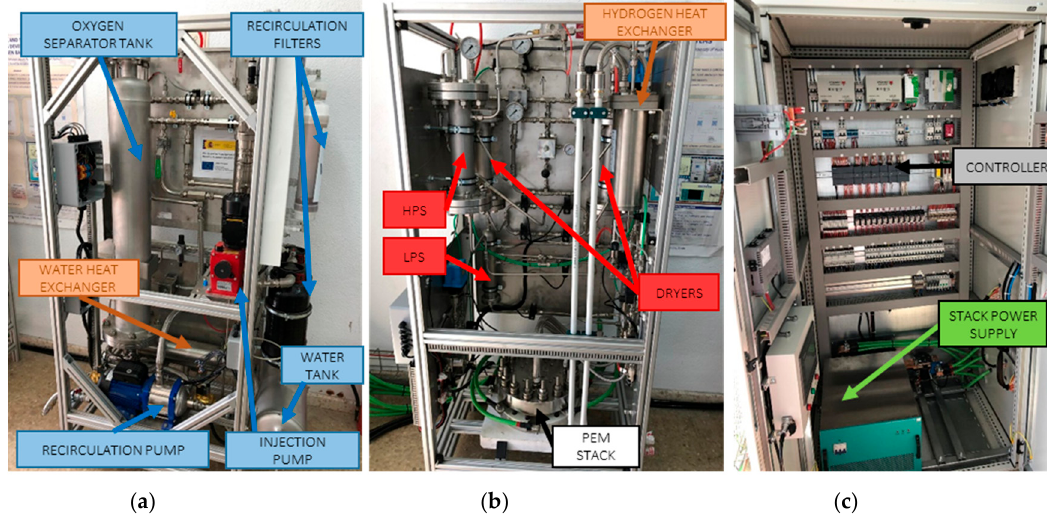
Figure 10. Detail of the PEM electrolyzer implementation: ( a ) Water management subsystem; ( b ) hydrogen subsystem; ( c ) stack power supply subsystem, control subsystem and all the power